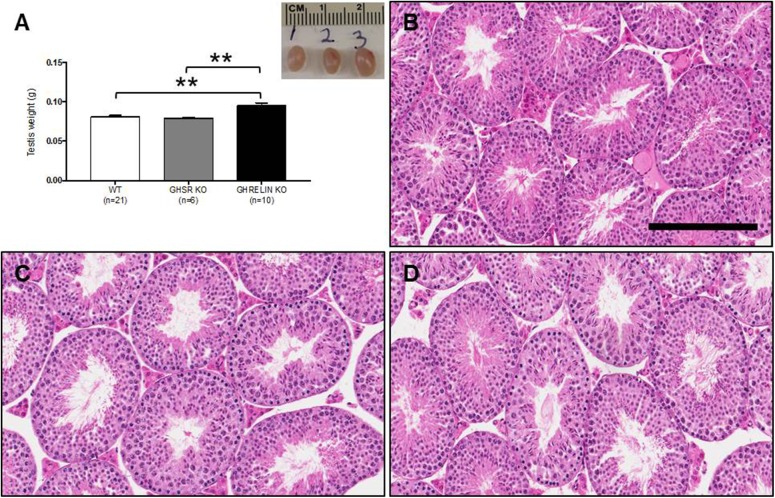
Increased testicular weight in ghrelin KO mice.A) Testicular weights and picture of WT, GHSR KO and Ghrelin KO testes. The right testis weight was significantly increased in ghrelin KO mice compared to the WT and GHSR KO mice (80 day old). No significant differences were detected in testis weight between WT mice and GHSR KO mice. Photomicrographs of testis cross-sections from 80 day old WT mice (B), ghrelin KO mice (C) and GHSR KO mice (D). Scale bar = 200 μm. Data were analyzed by one-way ANOVA multiple comparisons Bonferroni's test and expressed as mean ± SEM (** p<0.01).